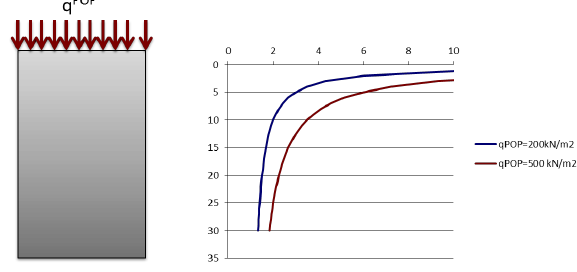
Figure 2: OCR profiles for assumed pre-overburden pressure values POP q .